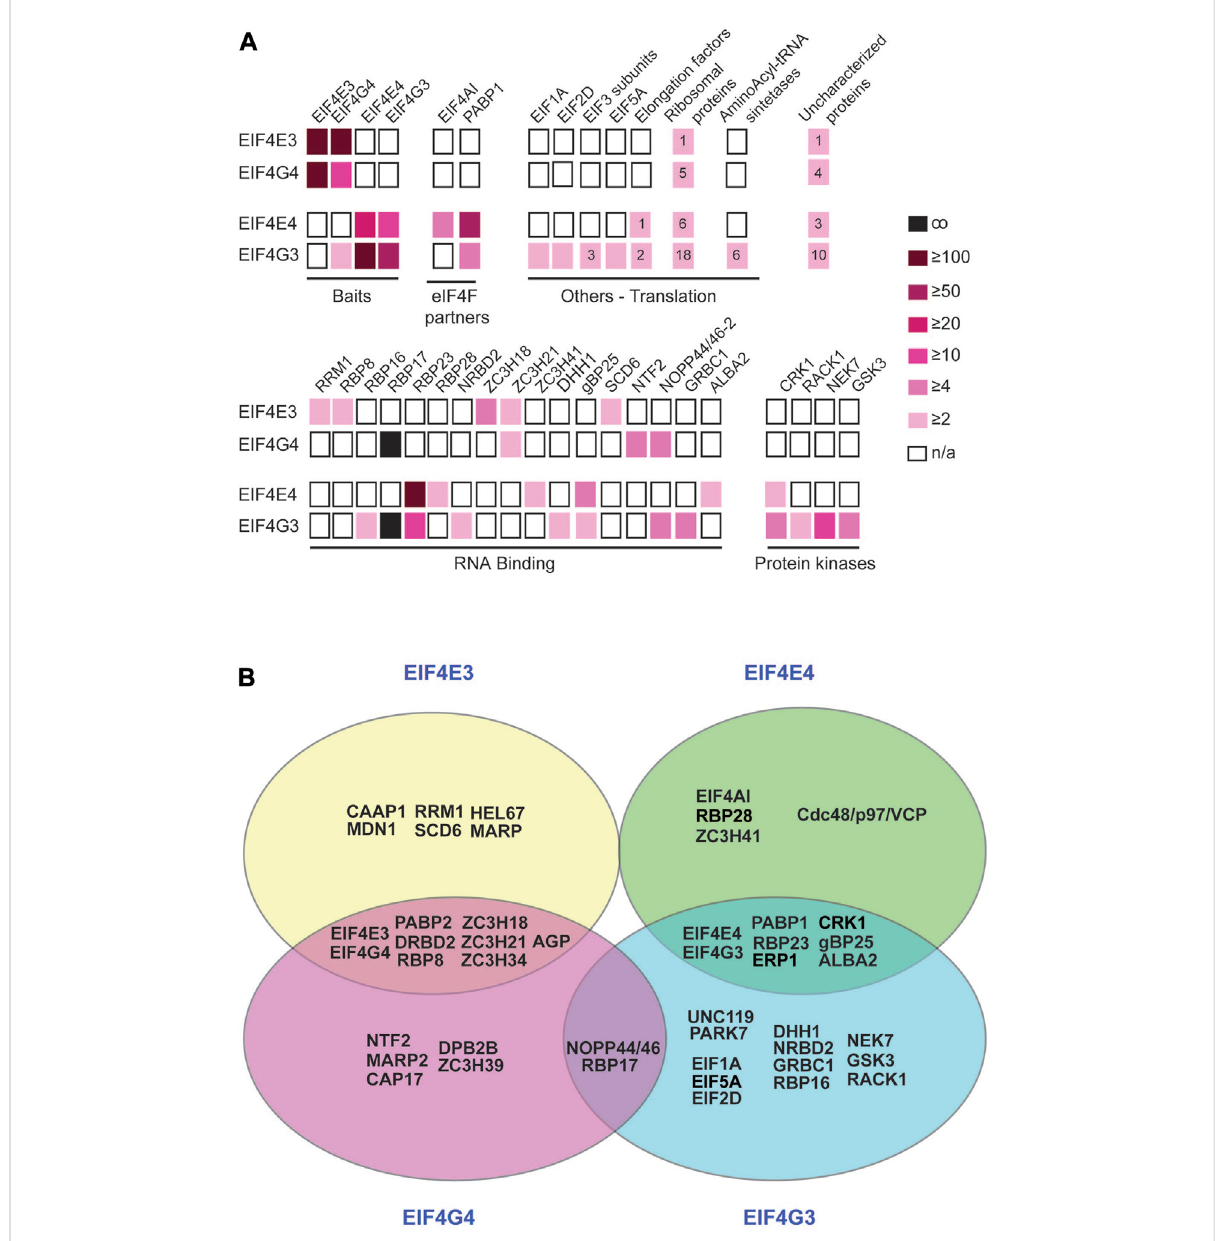
FIGURE 3 Comparative overview of selected proteins co-precipitated with the EIF4E3/EIF4G4 and EIF4E4/EIF4G3 complexes. (A) Proteins co- immunoprecipitated with each of the two sets of eIF4E and eIF4G homologues and belonging to selected functional categories are represented by boxes coloured according to the enrichment ratios derived from Supplementary Table S2. The numbers inside the boxes indicate the number of subunits of the named complex (including ribosomes) that have equivalent enrichment ratios. (B) Venn diagram summarizing the major results derived from the analyses shown in (A) and in the Supplementary Figure S2. Proteins co-precipitated with individual subunits or with the eIF4E or eIF4G pairs are also represented. Most enzymes and hypothetical proteins we opted to exclude since their functional roles in translation and/or mRNA metabolism, if any, remain to be de fi ned. For clarity and simpli fi cation, ribosomal proteins and other factors known to be required for translation per se were also not included, as well as many of the proteins found to be exclusively co-precipitated with